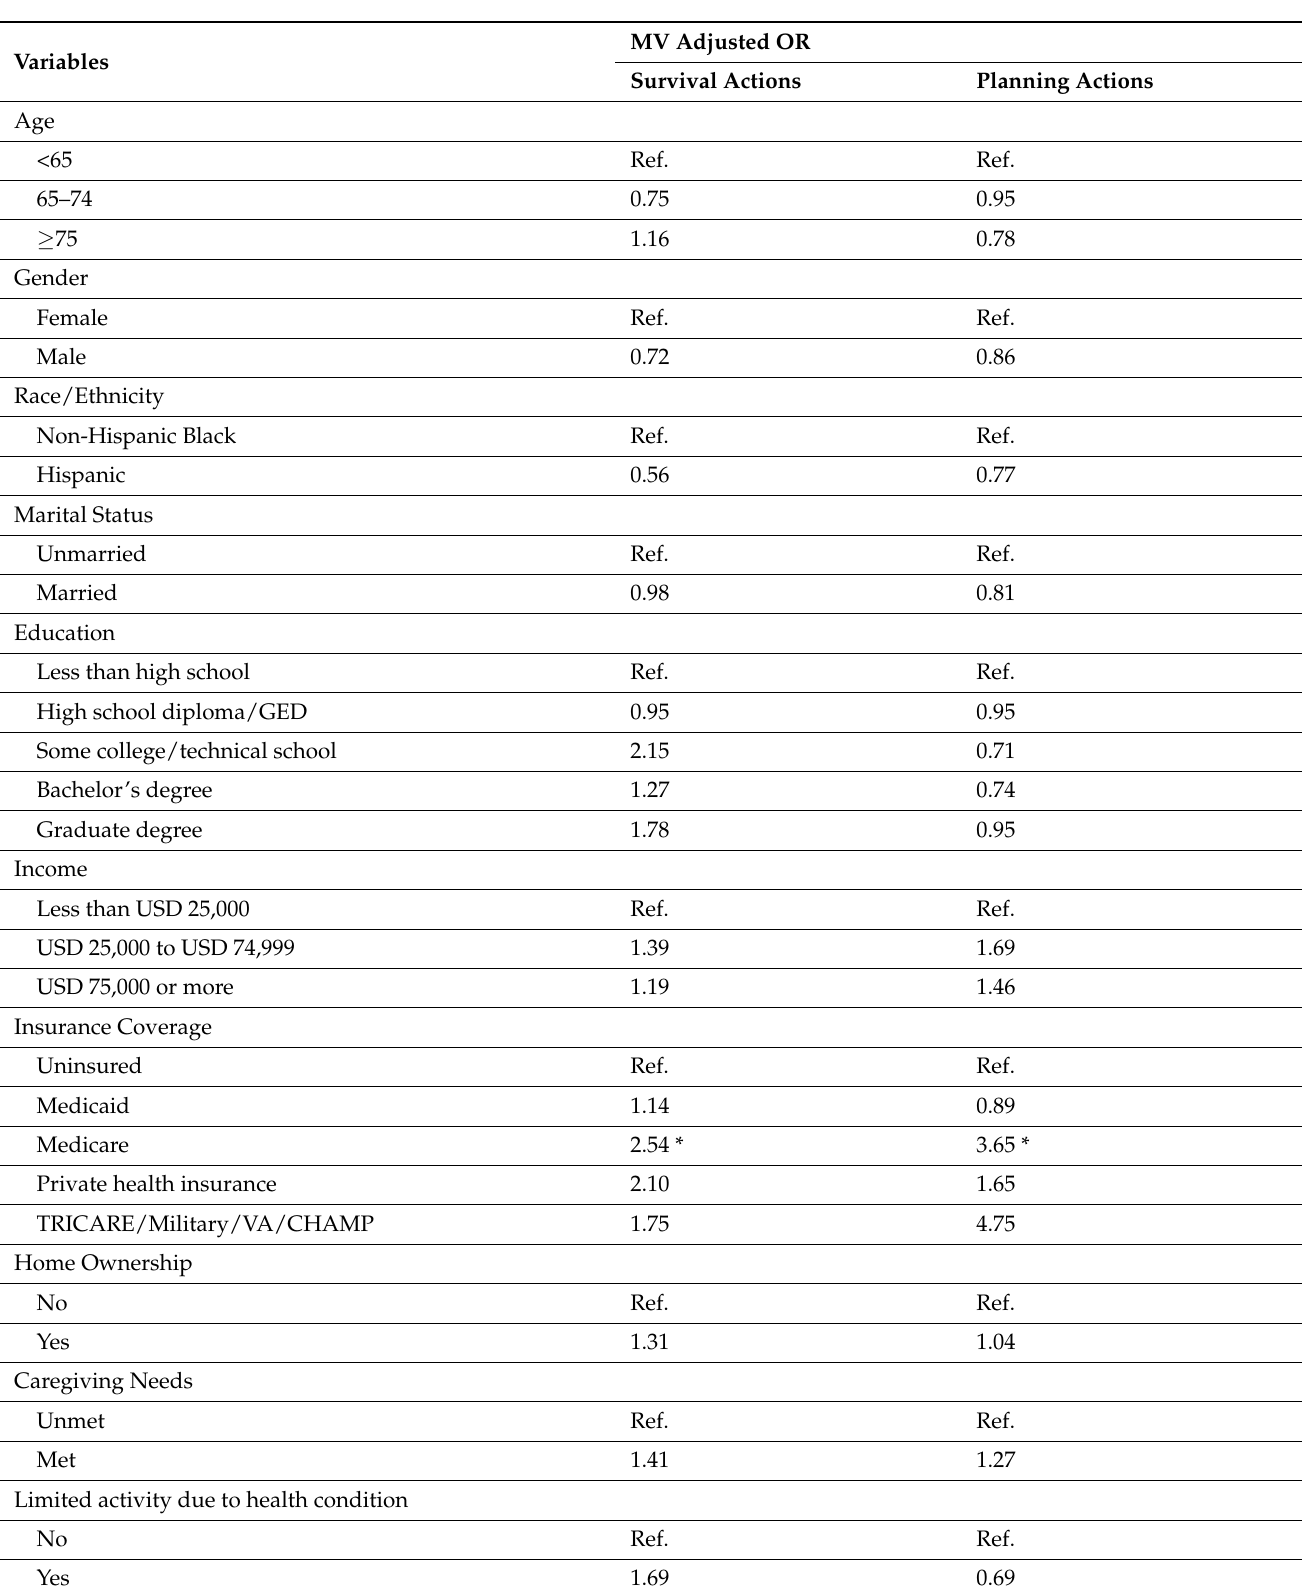
Table 2. Logistic Regression Modeling of the Relationship between Sociodemographic Characteristics and Survival and Planning Disaster Preparedness Actions ( n =